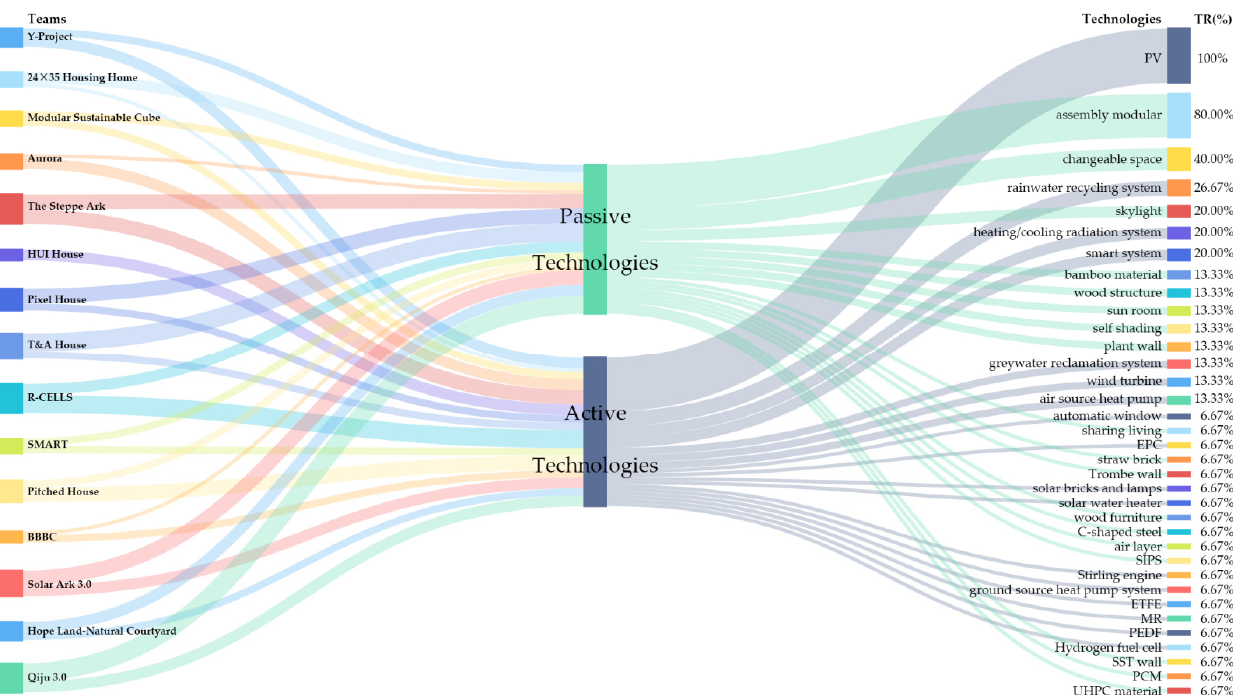
Figure 18. Summary of carbon neutrality technologies in the Third SDC.